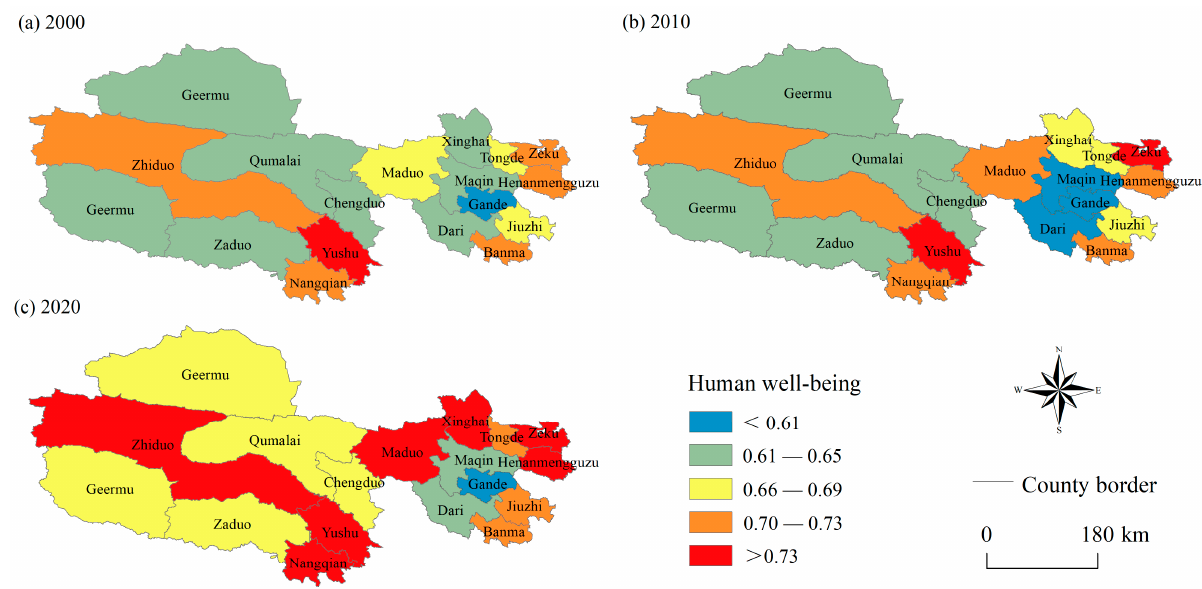
Figure 2. Spatiotemporal differences in the human well-being index (HWI) in the Sanjiangyuan area during 2000–2020.